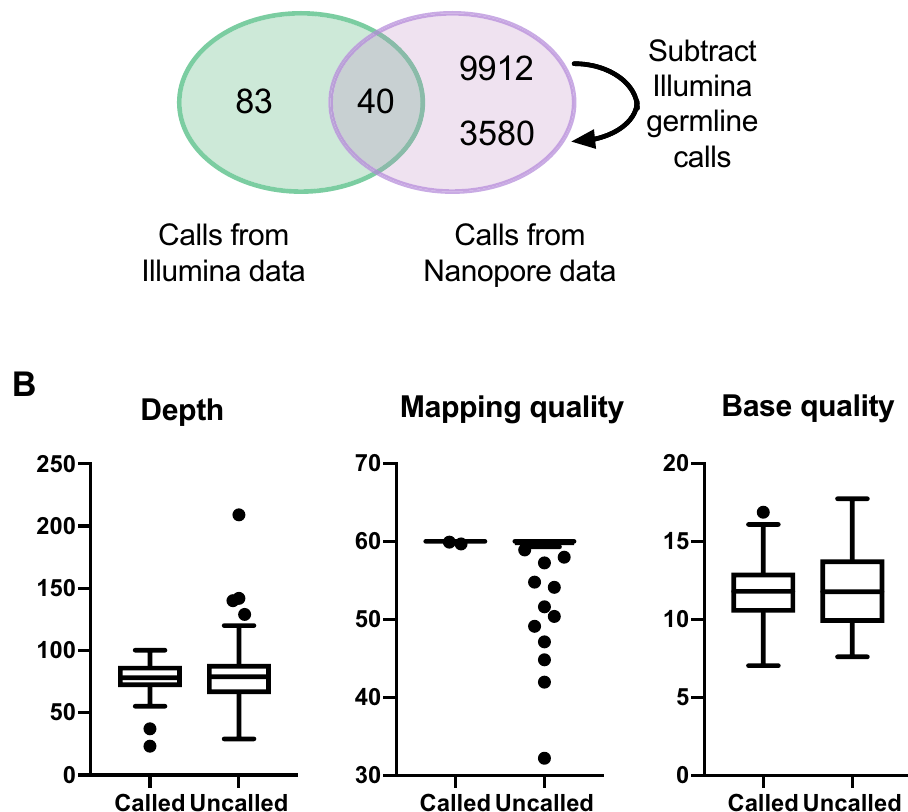
Figure 1. Comparison of somatic SNV calls from short-read and Nanopore data sets. ( A ) Venn diagram to show the overlap between somatic SNV calls from the short-read (green) and Nanopore (purple) data for chromosome 17. The two numbers in the Nanopore-only sector show the number of calls before (top) and after (bottom) subtraction of short-read germline calls. Note that the total number of Nanopore calls prior to subtraction is 9912 + 40 = 9952, and the total after subtraction is 3580 + 40 = 3620. ( B ) Read depth, average mapping quality and average base quality calculated from Nanopore reads covering each of the 123 sites at which an SNV is called in the short-read data. Sites are portioned into those at which an SNV was called vs uncalled in the Nanopore data. Boxes span the interquartile range, with the median marked as a horizontal bar, while whiskers mark the farthest points that are not